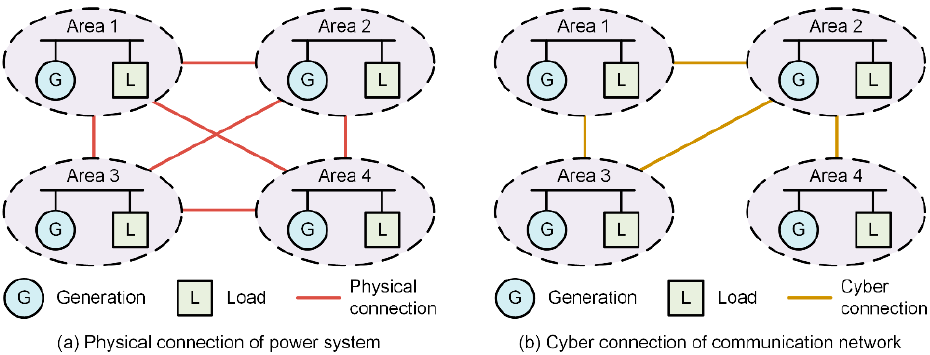
Figure 1. Relationship of power system and communication network.